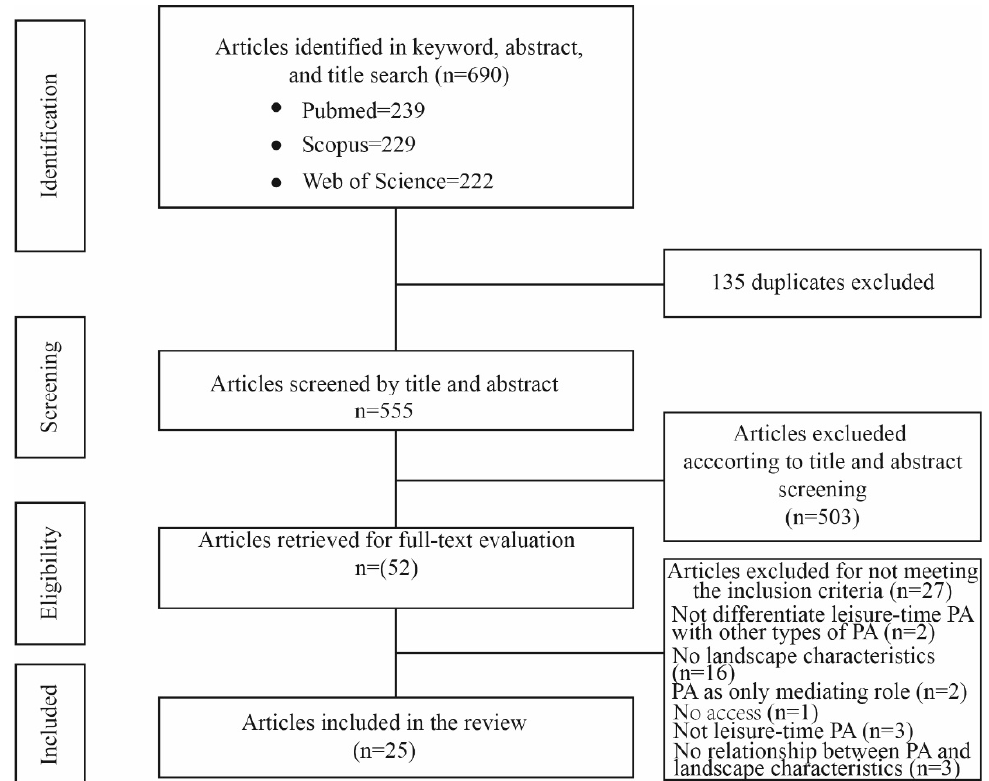
Figure 1. The flowchart of the study selection